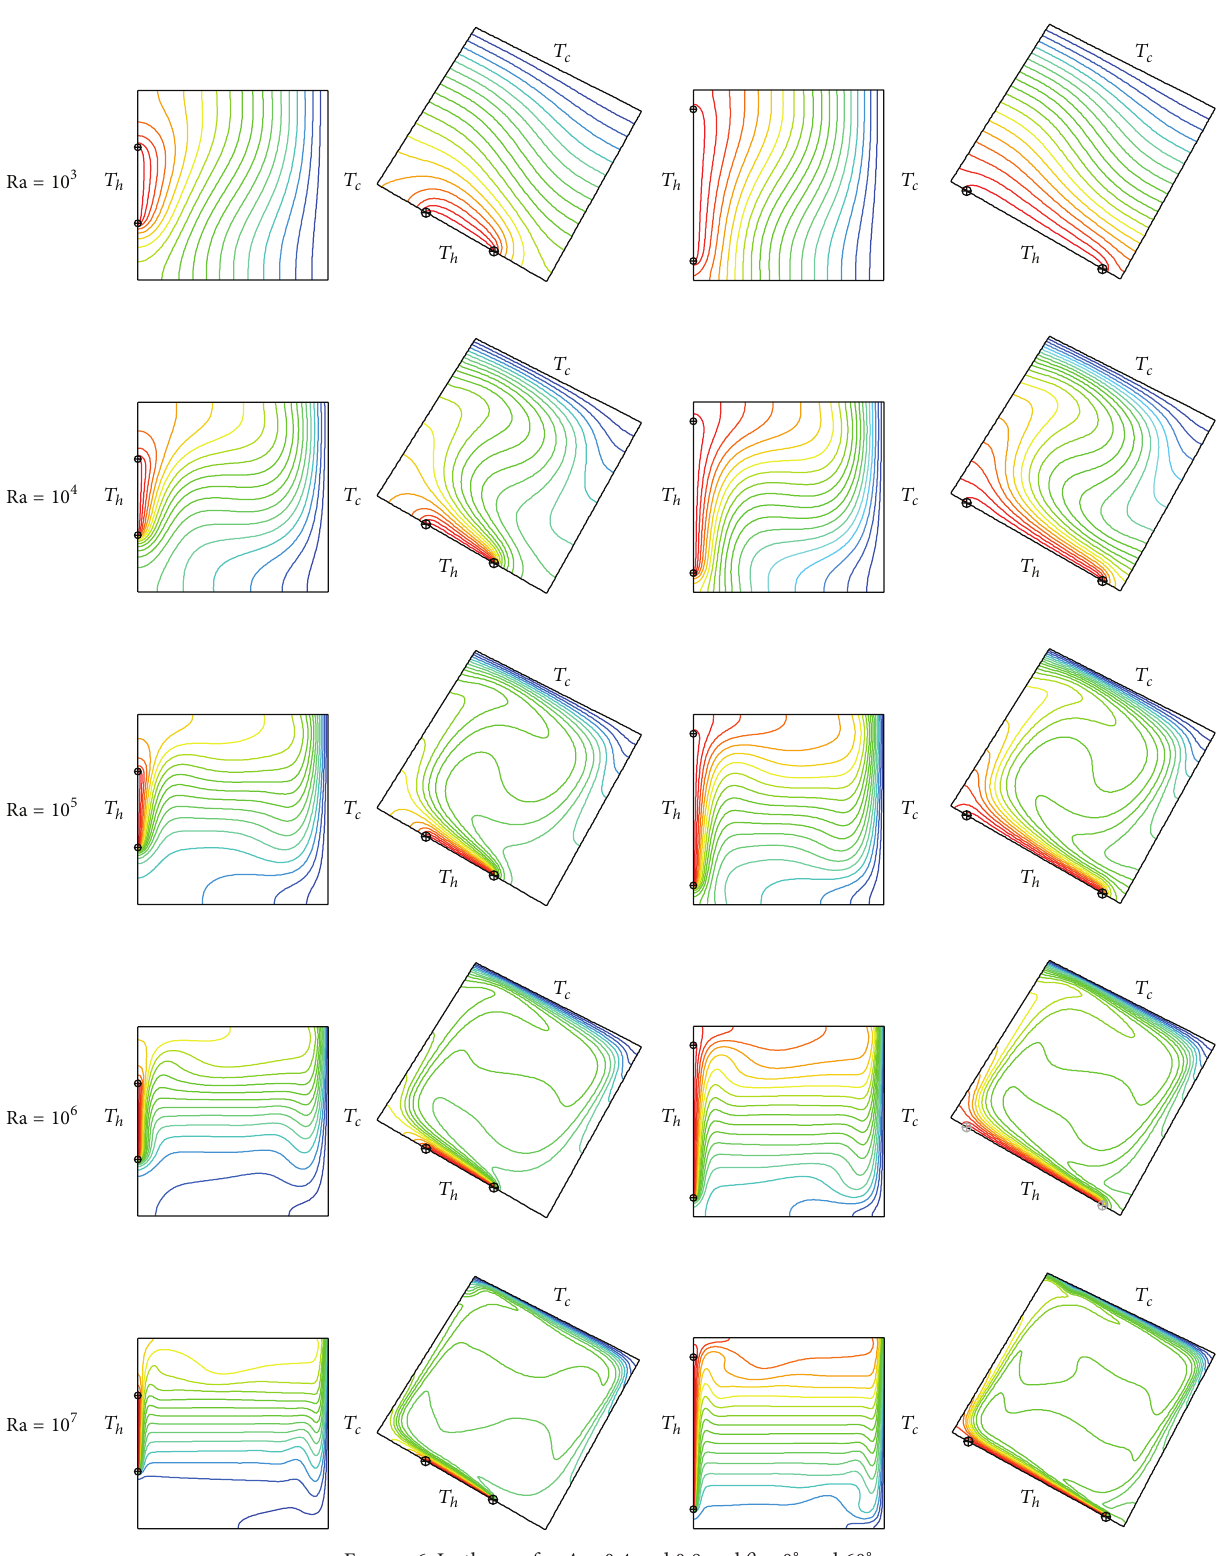
Figure 6: Isotherms for 𝐴 = 0.4 and 0.8 and 𝜃 = 0 ∘ and 60 ∘